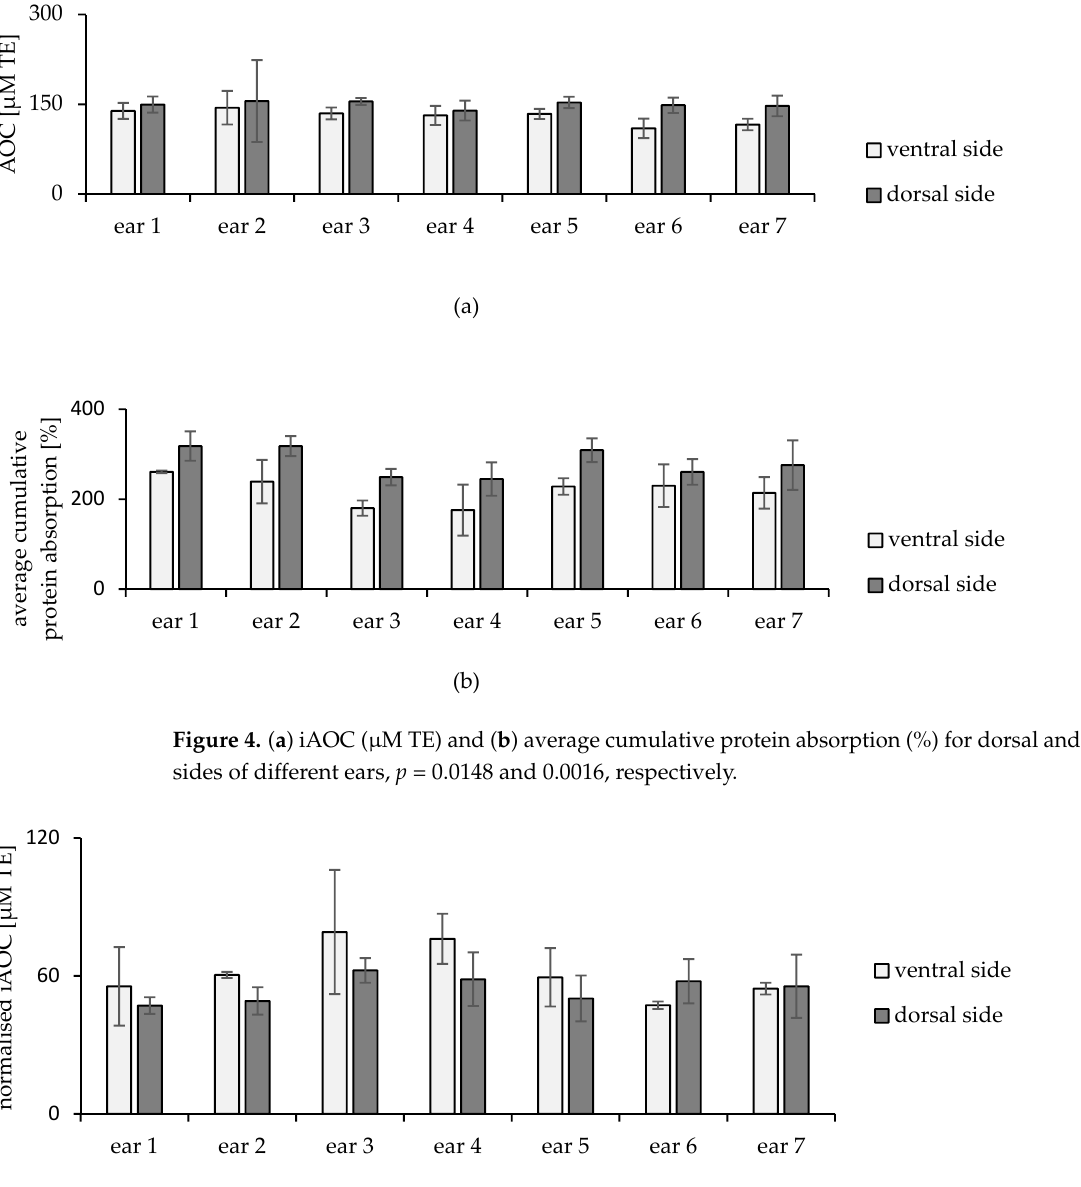
Figure 5. Normalised skin iAOC for dorsal and ventral ear sides.